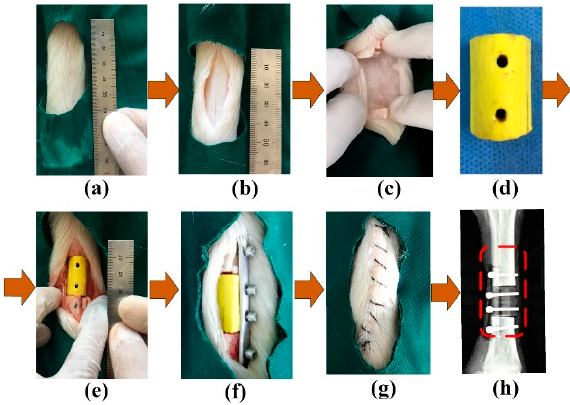
Figure 4. Implantation of the PAB: ( a ) sheep leg, ( b ) bone, ( c ) bone defect, ( d ) PAB, ( e ) implantation, ( f ) fixation, ( g ) suturing, and ( h ) X-ray image.